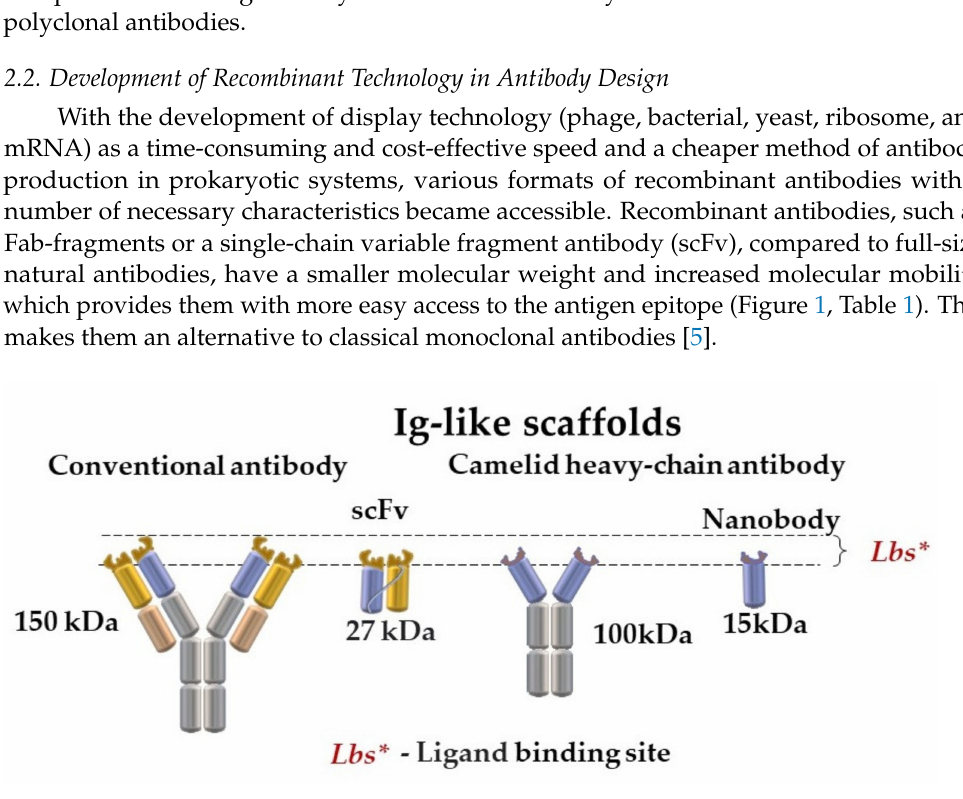
Figure 1. Immunoglobulin-like